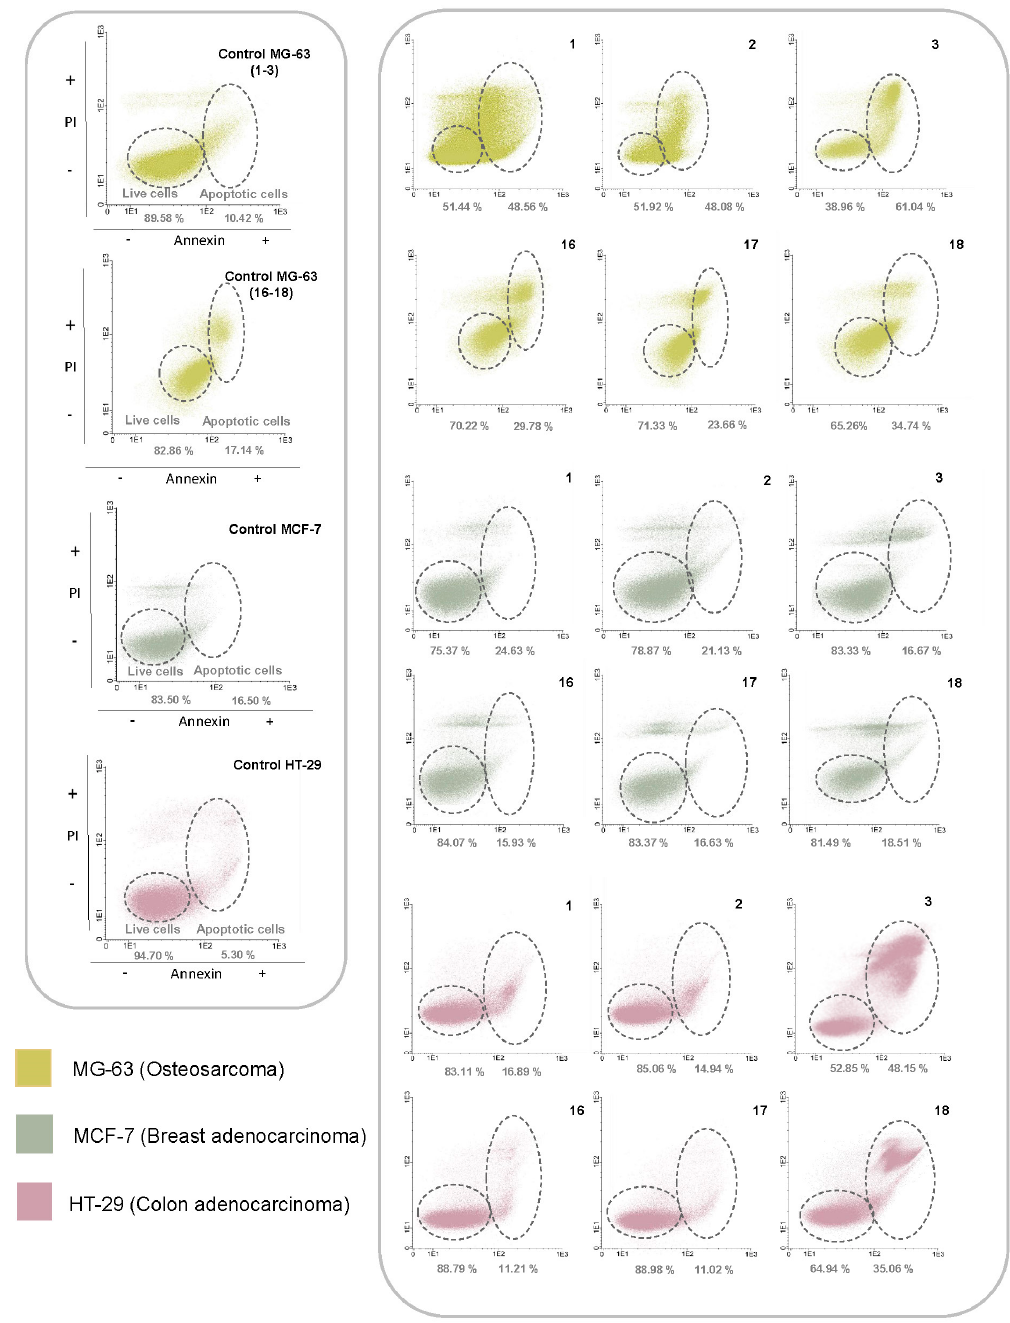
Figure 3. Apoptosis assays results observed by flow cytometry for the precursors 1 – 3 and the hybrids L-MHQs 16 – 18 in MG-63 (osteosarcoma), MCF-7 (breast cancer), HT-29 (colon adenocarcinoma) cells at 24 h of incubation at 1 µM. Control with vehicle (DMSO, <0.001%).